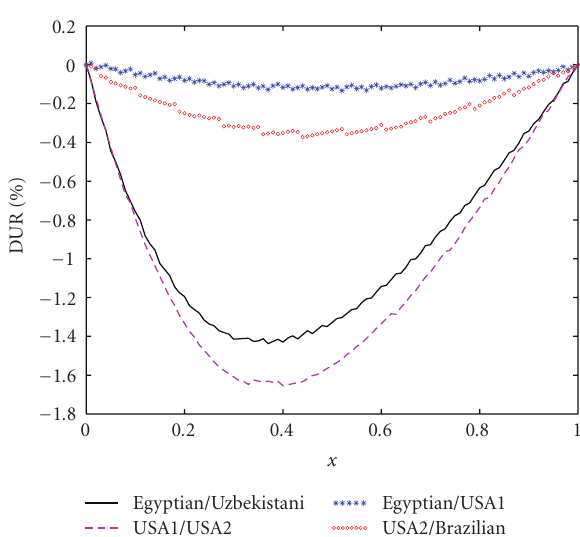
Figure 15: DUI% dependence to x .